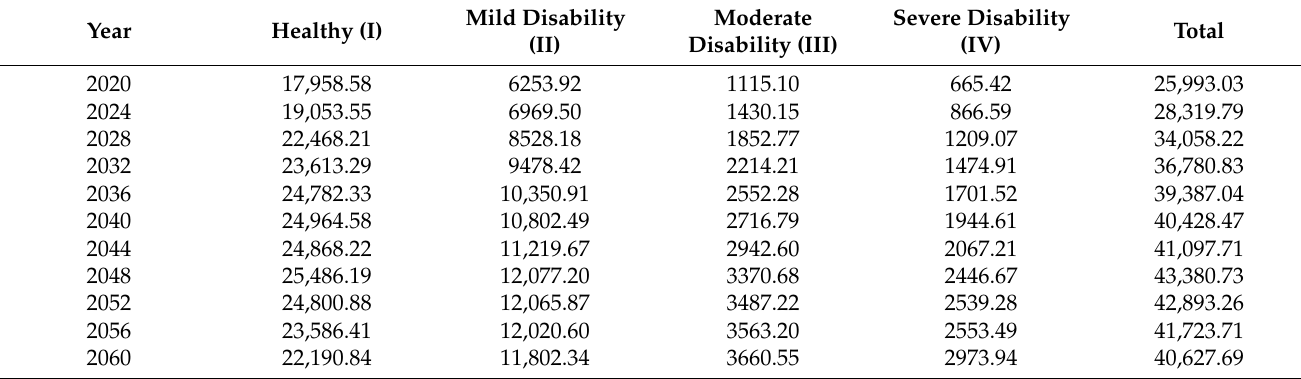
Table 5. Population distribution prediction for the different health states, 2020–2060 (unit: 10,000 people).